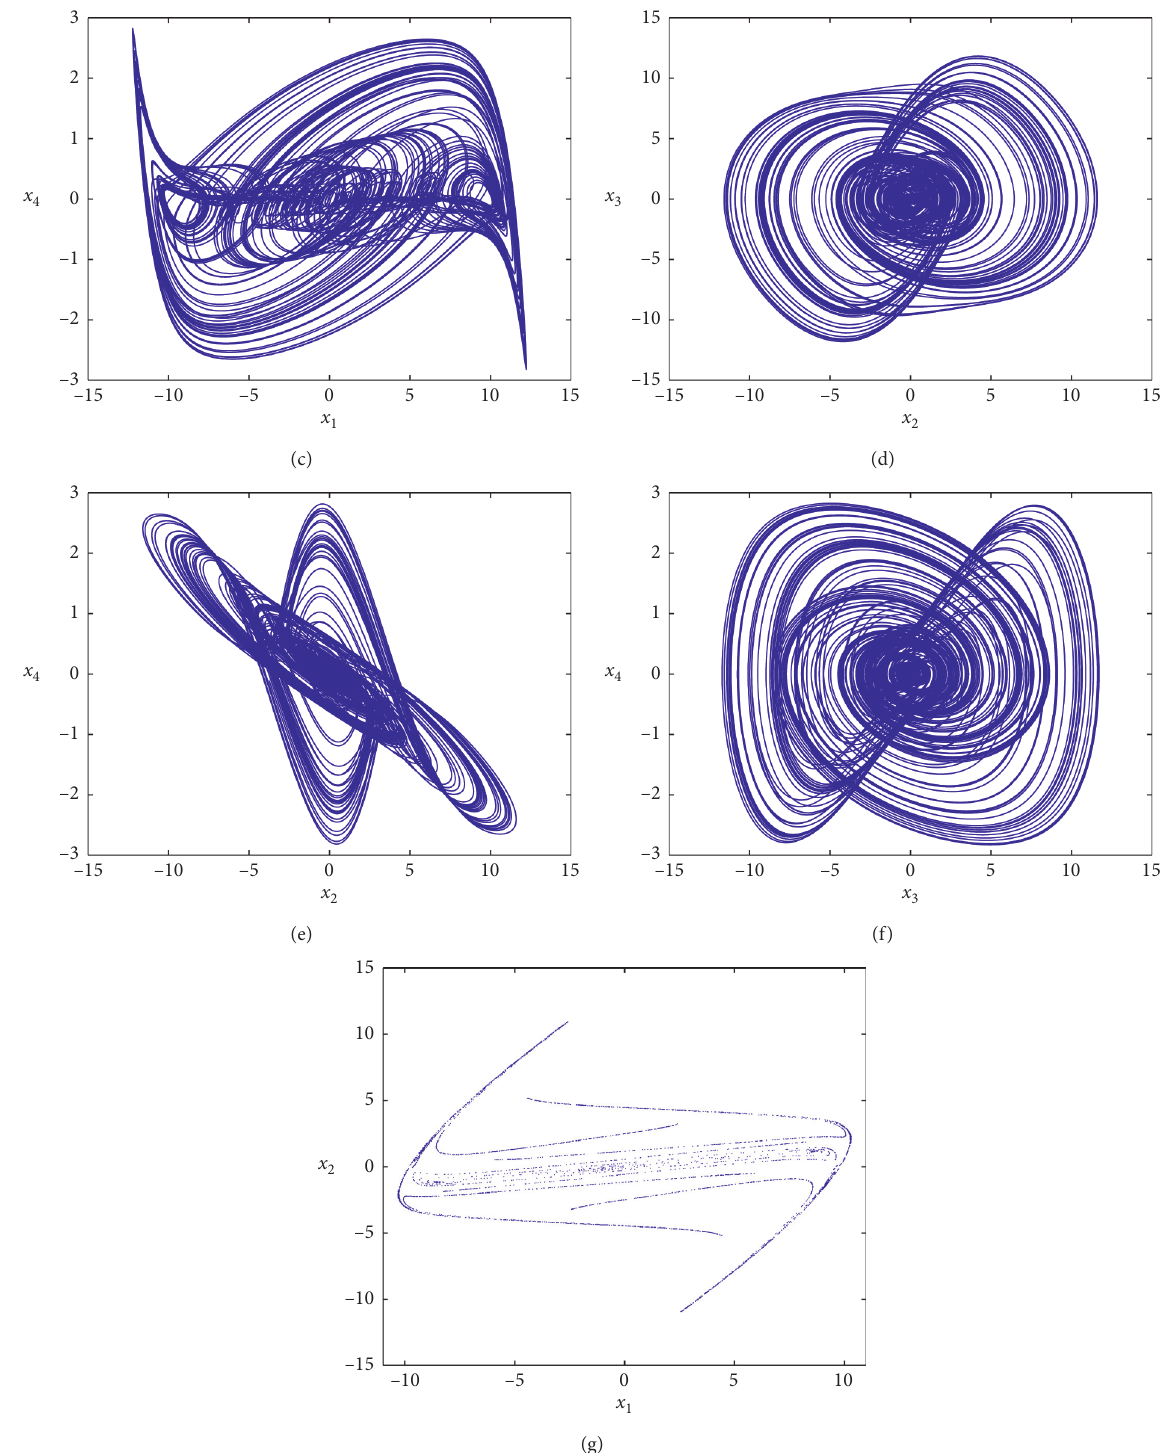
Figure 5: 2-D projection of the phase portraits of symmetric double-band chaotic attractors (a-f) of system (3) plotted into planes ( x − x − x − x )andcorrespondingdouble-sidedPoincar´e section( e )intheplane x ),( x ),( x ( x 2 3 2 4 3 4